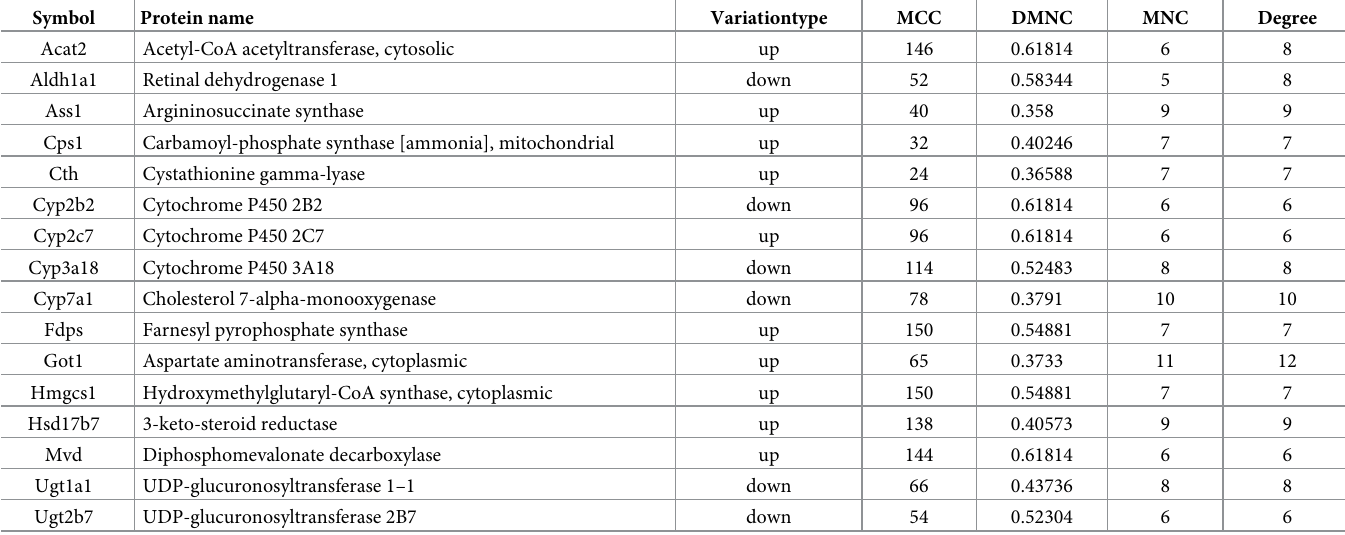
Table 4. The topological parameters of hub proteins in the interactive network of differential